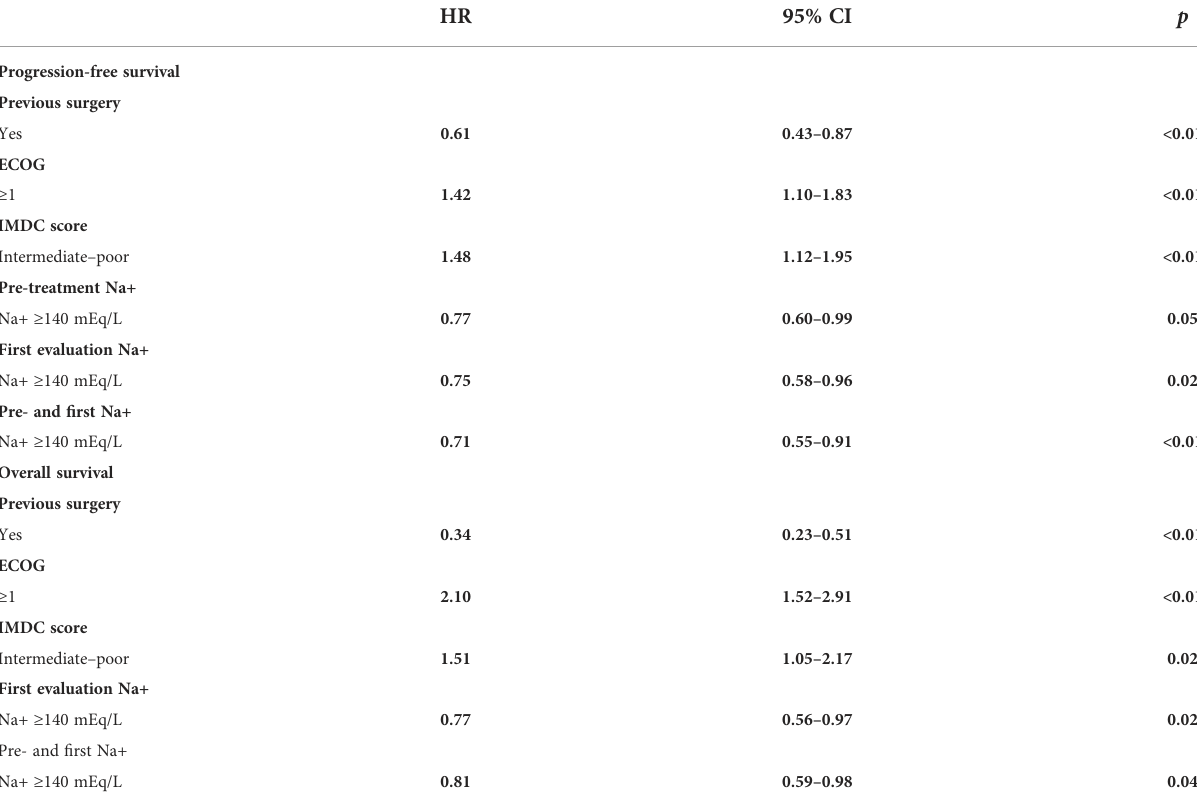
TABLE 4 Multivariate analysis for PFS and OS.